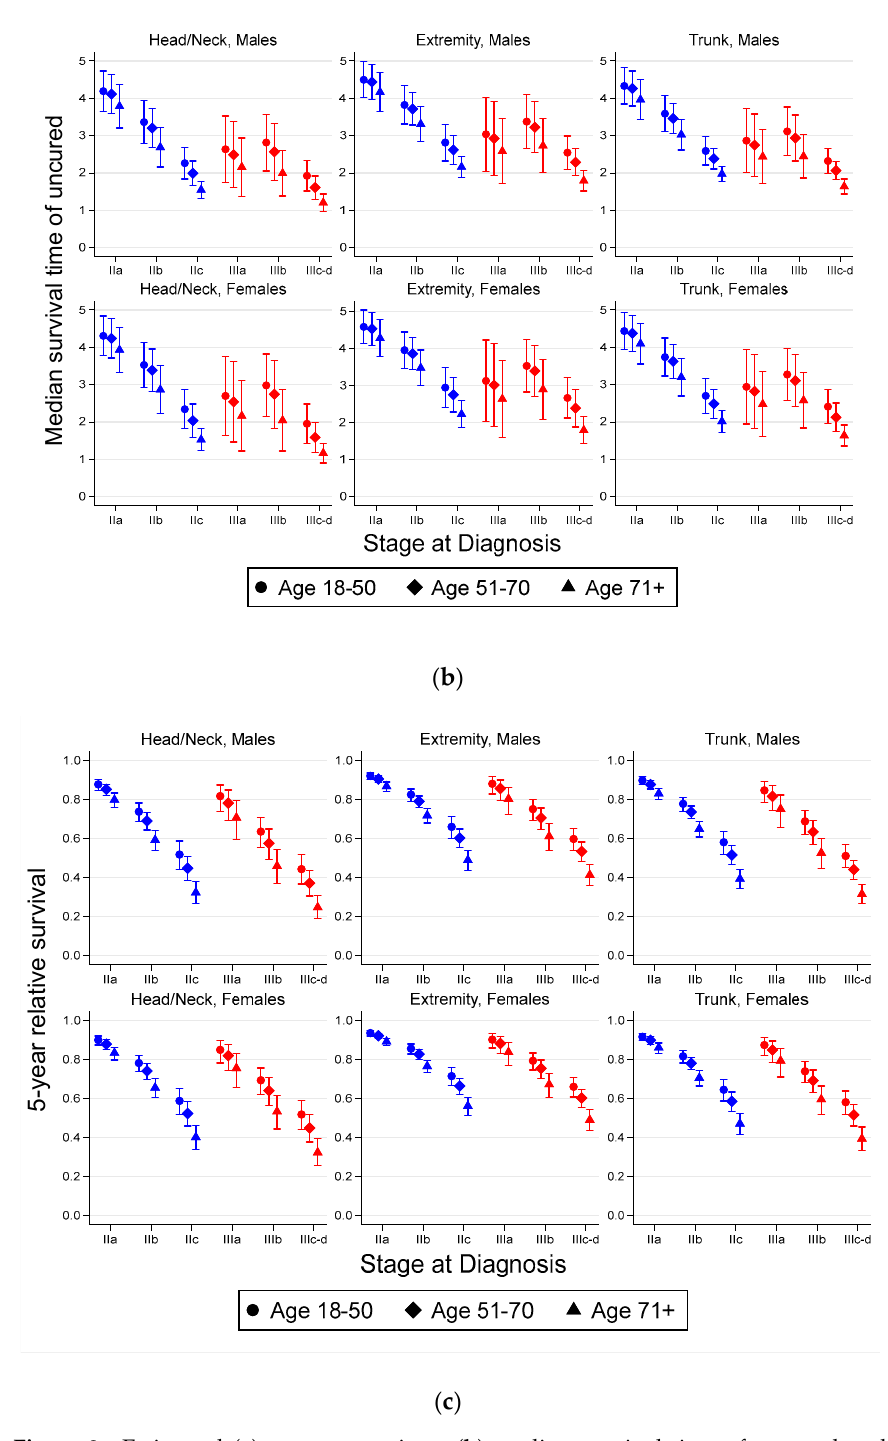
Figure 2. Estimated ( a ) cure proportions, ( b ) median survival time of uncured and ( c ) 5-year relative survival (with 95% confidence intervals), for men and women, respectively, diagnosed with stage II–III cutaneous melanoma in Sweden, 2005–2013.